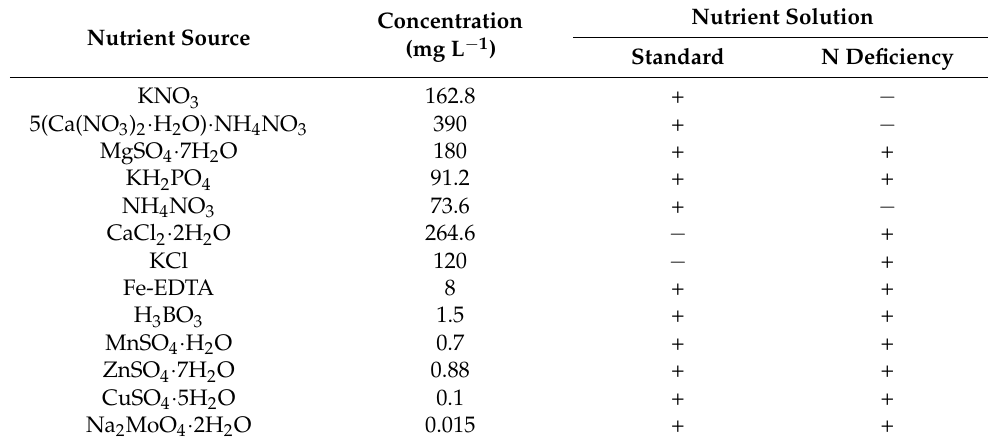
Table 2. Nutrient solution concentration for standard or N deficiency treatment